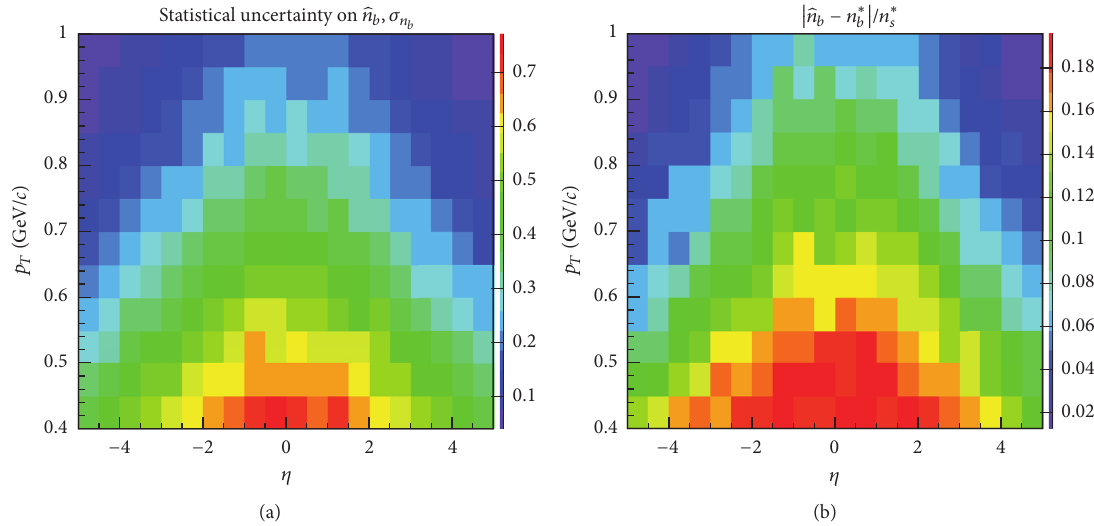
Figure 6: (a) Statistical uncertainty on the estimated number of soft QCD particles, 𝜎 𝑛 the events generated for this study. (b) Absolute deviation of the estimated number of soft QCD particles from the corresponding true value, normalised to the true number of signal particles, |̂𝑛 𝑏 − 𝑛 ∗ 𝑏 |/𝑛 ∗ 𝑠 , as a function of particles 𝜂 and 𝑝 𝑇 , averaged over the events generated for this study. The plots confirm the level of precision and accuracy that can be achieved using this method, in that 𝜎 𝑛 |̂𝑛 − 𝑛 ∗ |/𝑛 ∗ 𝑏 𝑏 𝑠 is significantly lower than